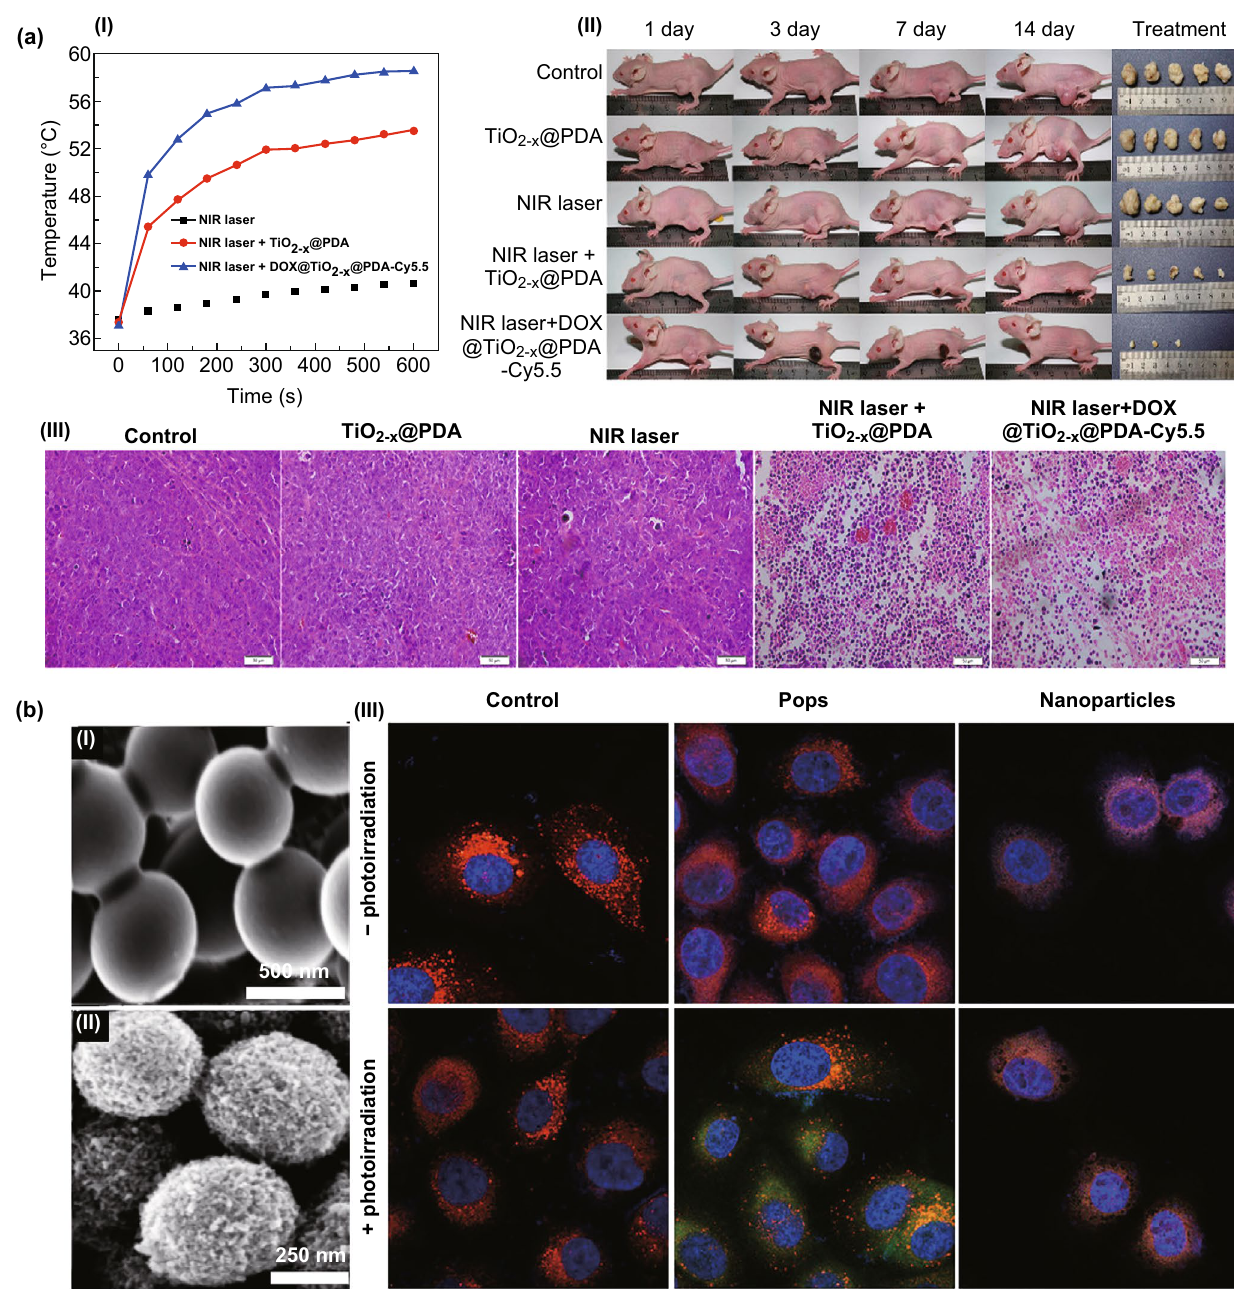
Fig. 7 a Black TiO 2 nanocarriers employed for a chemo/photodynamic/photothermal therapy in vivo. The efficient temperature raise (a‑I) caused by black TiO 2 nanocarriers (DOX@TiO 2−x @PDA‑Cy5.5) under NIR irradiation (808 nm, 1.0 W cm −2 ) triggers (a‑II) a tumor growth inhibition. (a‑III) Histological sections of the treated tumors indicate a noticeable cellular necrosis and apoptosis. Adapted from Ref. [47]